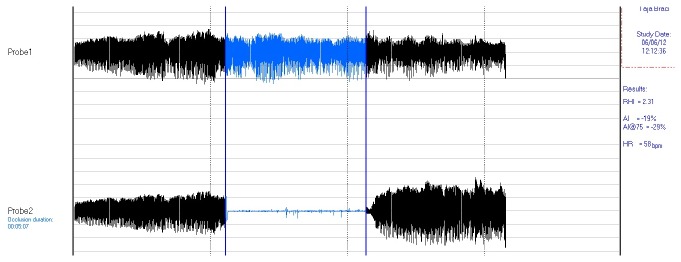
Typical PAT trace recorded on EndoPAT software.Suprasystolic pressure of the blood pressure cuff was confirmed by a flat line (seen in bottom trace) instead of pulsatile flow during occlusion. The EndoPAT index was calculated by the software and represents the ratio of the post occlusion PAT signal to the baseline signal.